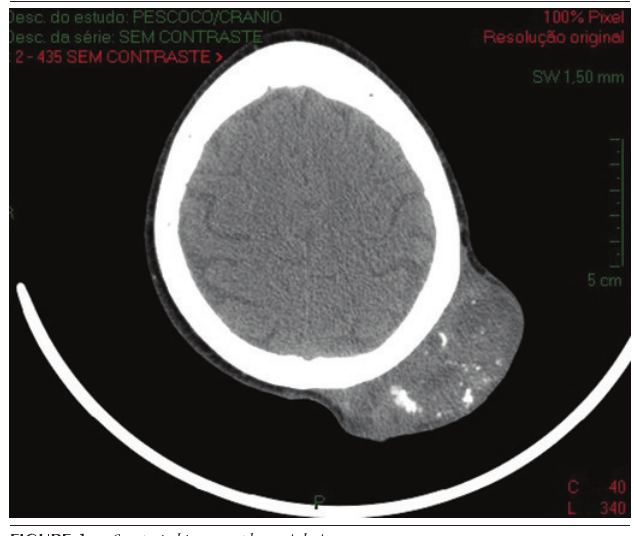
figurE 1 − Computed tomography, axial view Hypodense scalp lesion, with calcifications without periosteal invasion, in left parietal- temporal region. Source: PACS-Inca. Rio de Janeiro, October/2015.